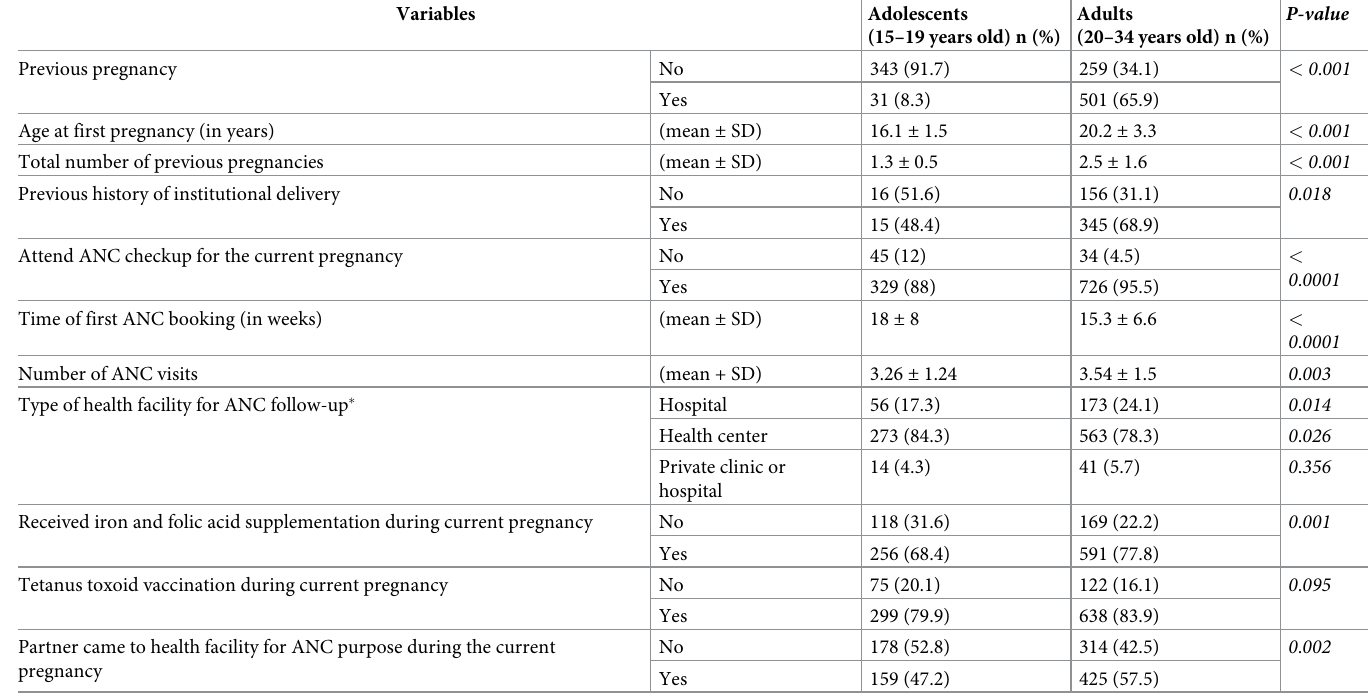
Table 2. Obstetric characteristics of women who gave birth at public health facilities in East Gojjam zone, northwest Ethiopia, 2018.